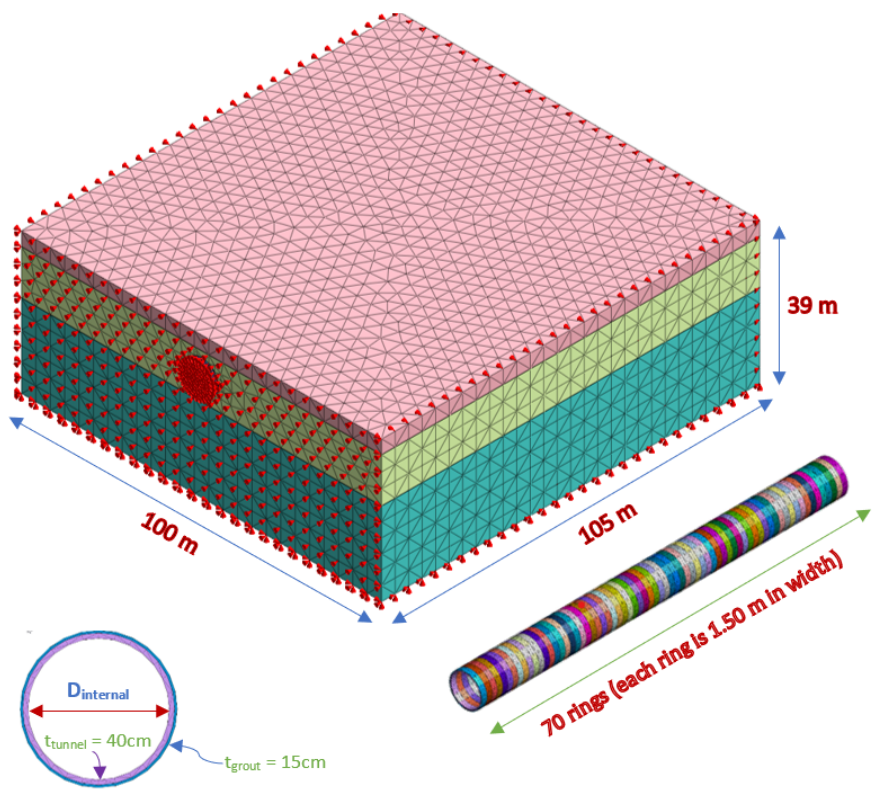
Figure 11. F.E. modeling for tunnel and surrounding soil.